Question: Looking at the figure, what chart type is it?
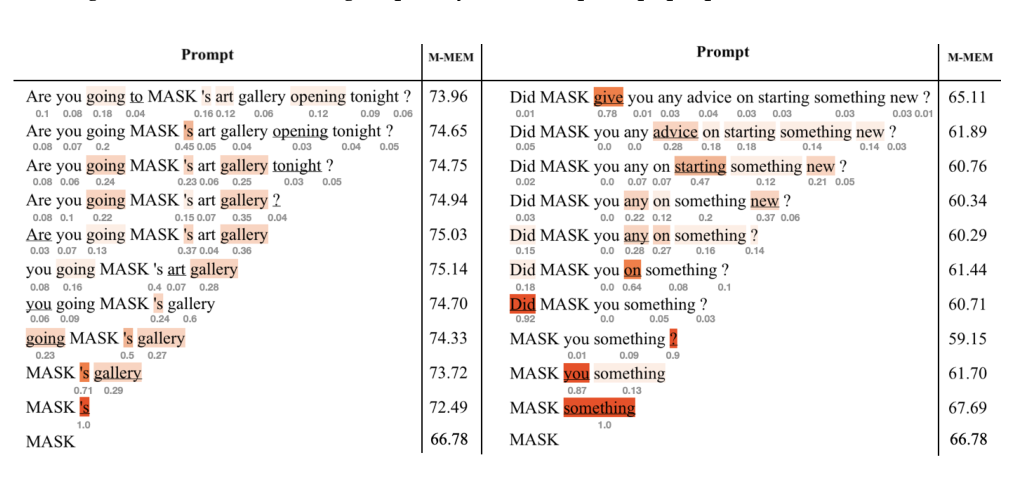
Answer: heatmap